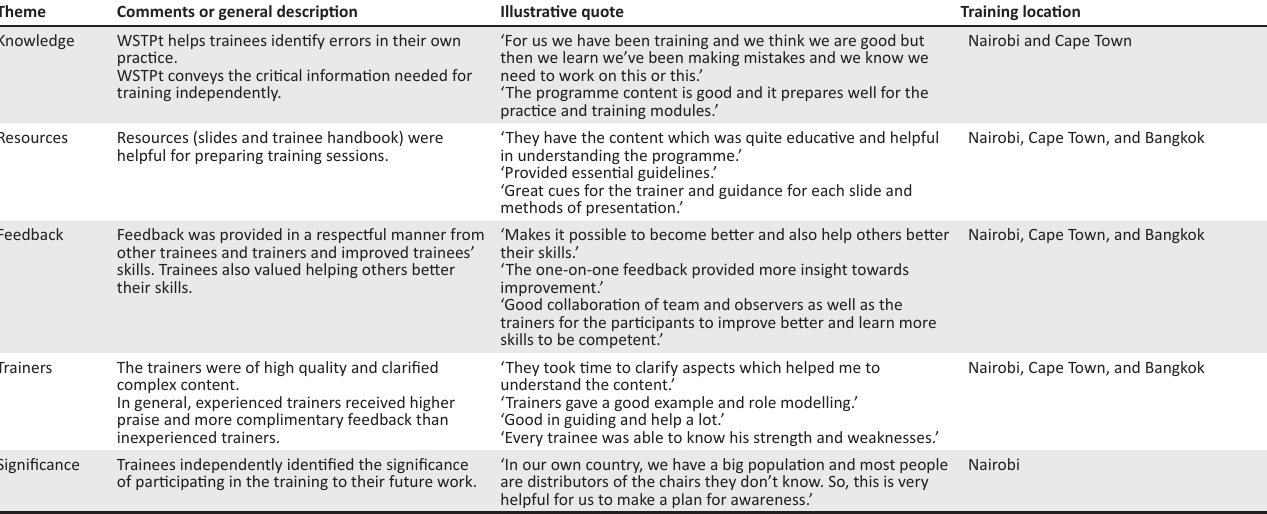
TABLE 4: Frequent themes from trainees from satisfaction surveys.